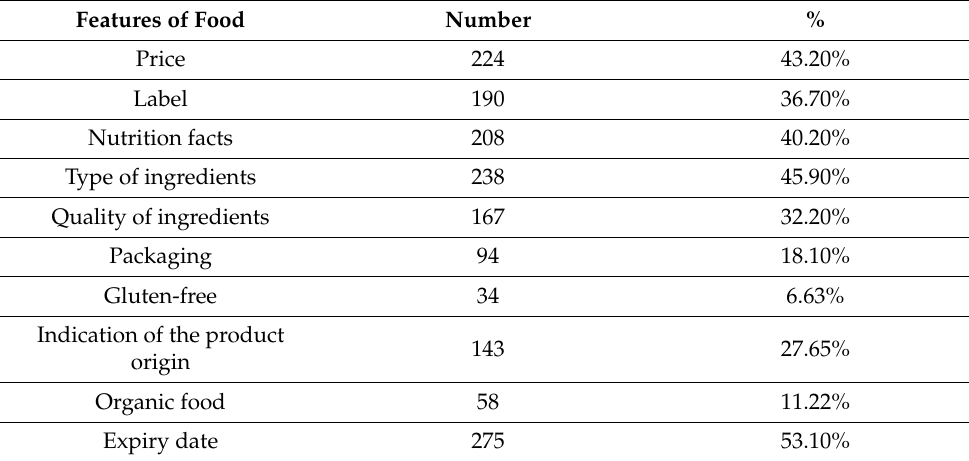
Table A4. Self-level attention on the features of food among the sample (in % of respondents).